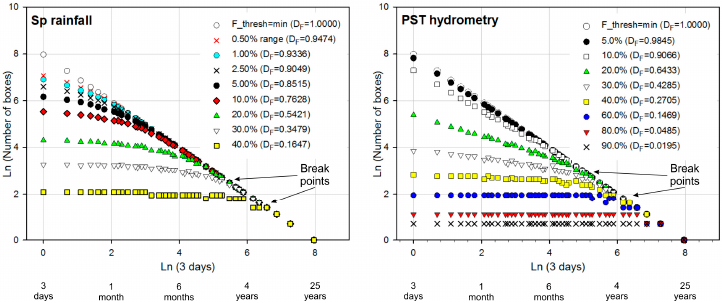
Figure 13. Rainfall and river level outcomes; fractal dimensions related to different F_threshold events; rainfall F_threshold > 40%: D F 00.0 .